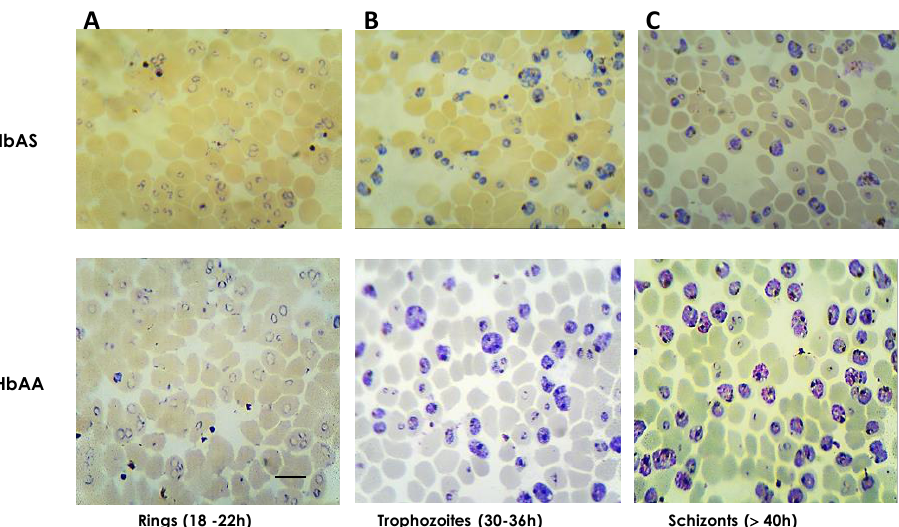
Figure 2. Synchronous cultures of P. falciparum 3D7 asexual stages. Parasites were grown in HbAA and HbAS red blood cells (RBCs). Asexual typical forms were harvested for different stages. ( A ). Late rings (14 – 20 h), ( B ). mature trophozoites (30 – 36 h) and ( C ). schizonts (>40 h). Smears were stained with Giemsa 10% and magnified 100×. Scale bar = 10 μm .